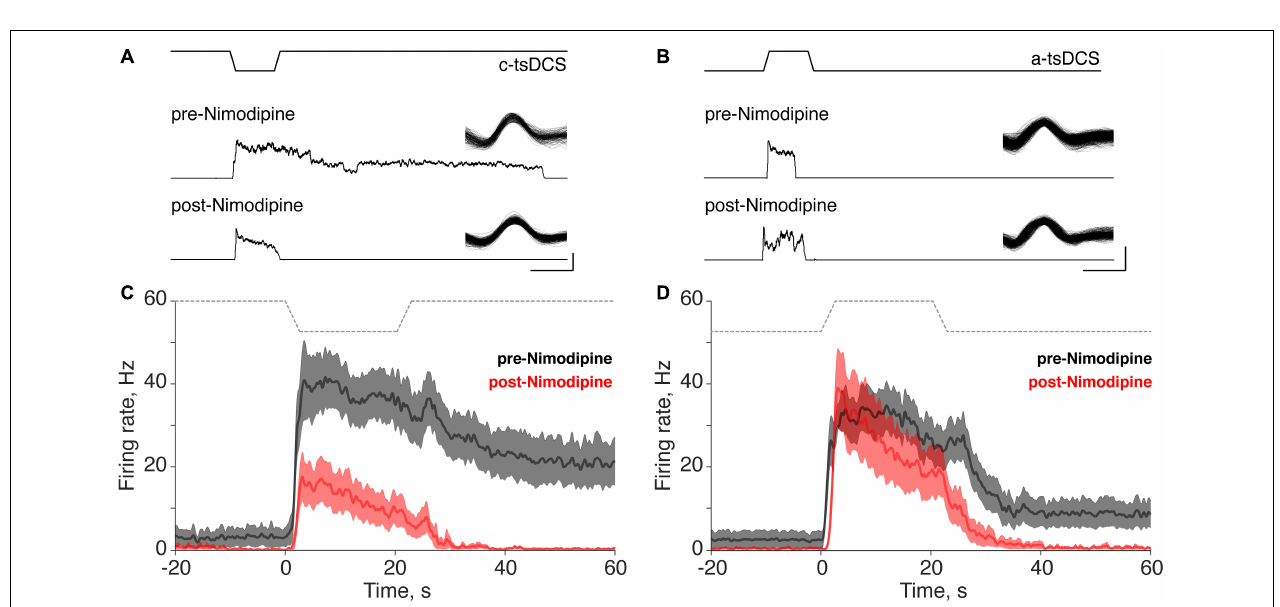
FIGURE 4 | Effect of the L-type calcium channel blocker Nimodipine on direct and persistent responses of trans-spinal direct current stimulation (tsDCS) ( ± 3 mA). (A,B) Typical responses of single motor units before and after Nimodipine application during cathodal-tsDCS (c-tsDCS) (A) and anodal-tsDCS (a-tsDCS) (B) . From top to bottom, we show the tsDCS waveform, and pre- and post-Nimodipine unit histograms. The inset shows the waveform of the isolated motor unit. C-tsDCS induced both direct responses and persistent responses. For c-tsDCS, Nimodipine reduced the direct response and blocked the persistent response. Nimodipine did not change the response during a-tsDCS stimulation but did block the brief persistent response. The single unit waveforms were identified from the sorted single motor units from the raw data and the smoothed firing rate (1s window) before and after Nimodipine. (C,D) The ensemble response from all the recorded units shows that Nimodipine completely blocked the persistent response and also suppressed the direct response during c-tsDCS (C) . By contrast, a-tsDCS did not significantly affect the direct response during a-tsDCS (D) . The thick lines and shaded area (C,D) represent mean ± SE, and gray lines indicate the applied tsDCS.